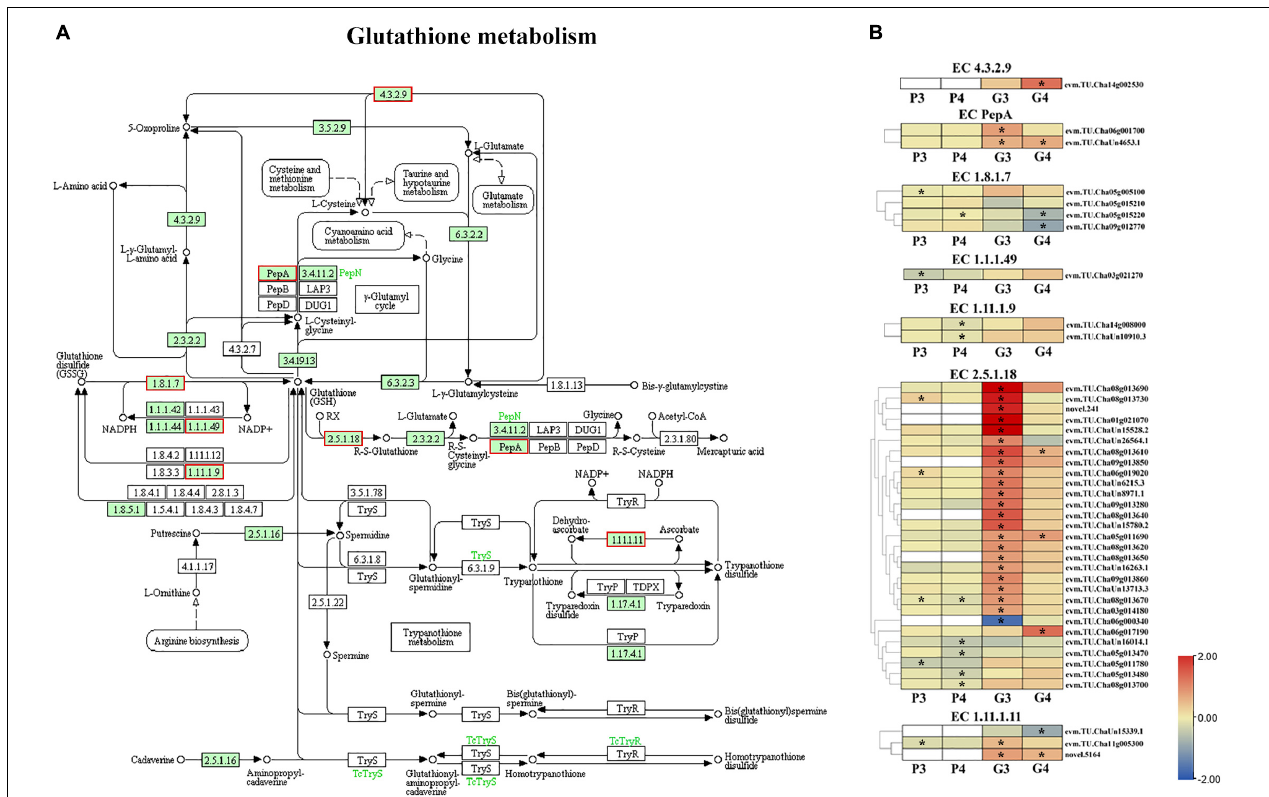
FIGURE 6 | Genes and proteins involved in glutathione metabolism pathway. (A) Red rectangles represent DEGs or DEPs. (B) DEG and DEP heatmaps. P3 and P4 represent DEPs for Na 2 SeO 3 vs. control and for Na 2 SeO 4 vs. control, respectively. G3 and G4 represent DEGs for Na 2 SeO 3 vs. control and for Na 2 SeO 4 vs. control, respectively. Different colors indicate different levels of protein or gene expression based on log 2 FoldChange. White rectangles indicate no DEGs or DEPs. Asterisks represent DEPs with P < 0.05 or DEGs with padj < 0.05.